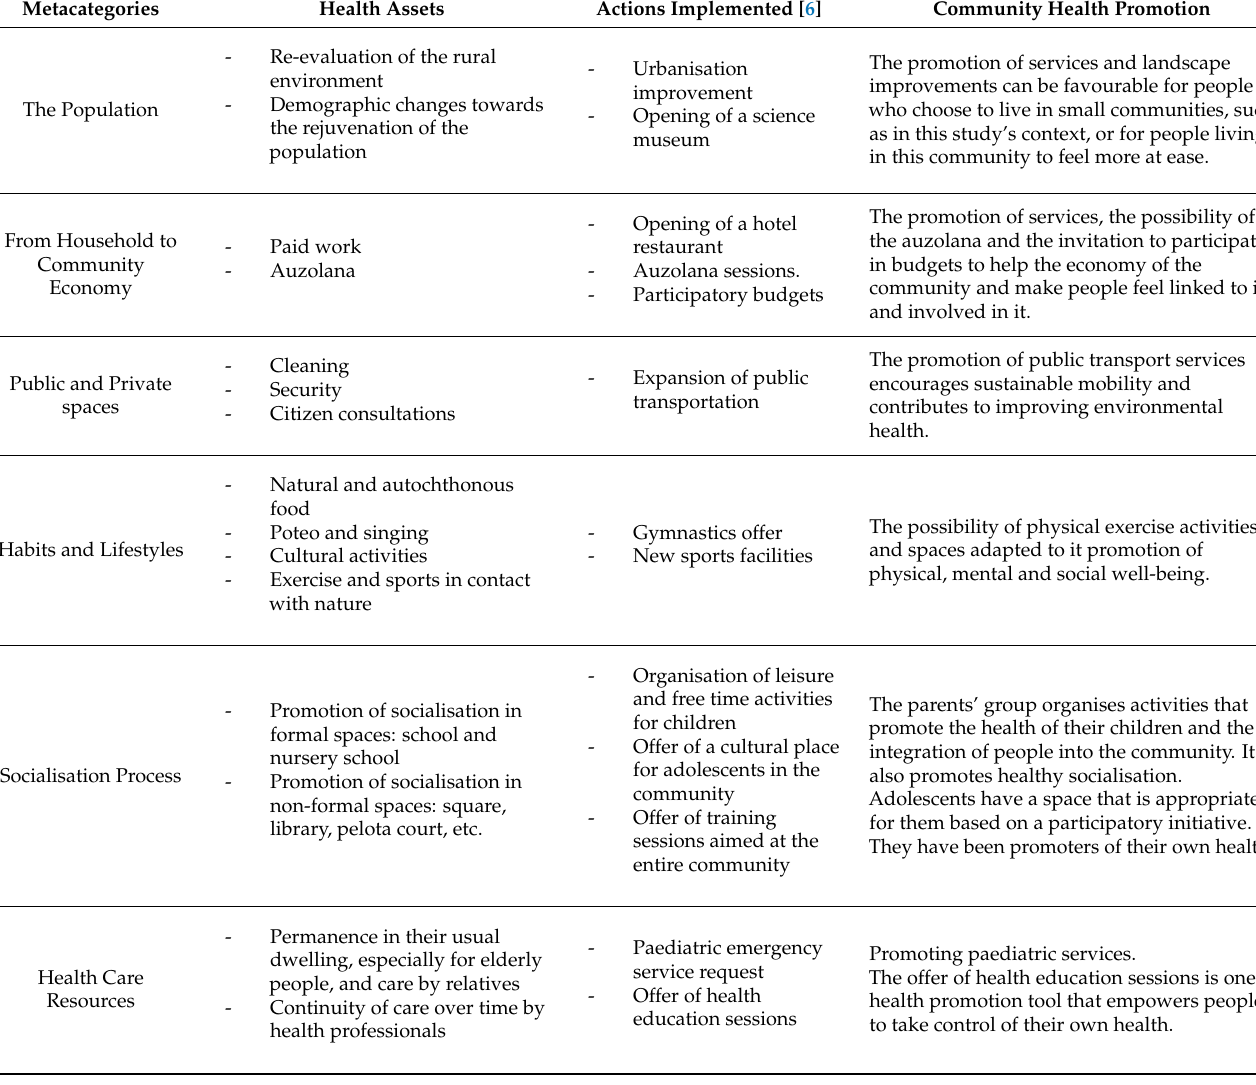
Table 2. Assets and actions implemented in the community grouped into meta-categories and their impact on health